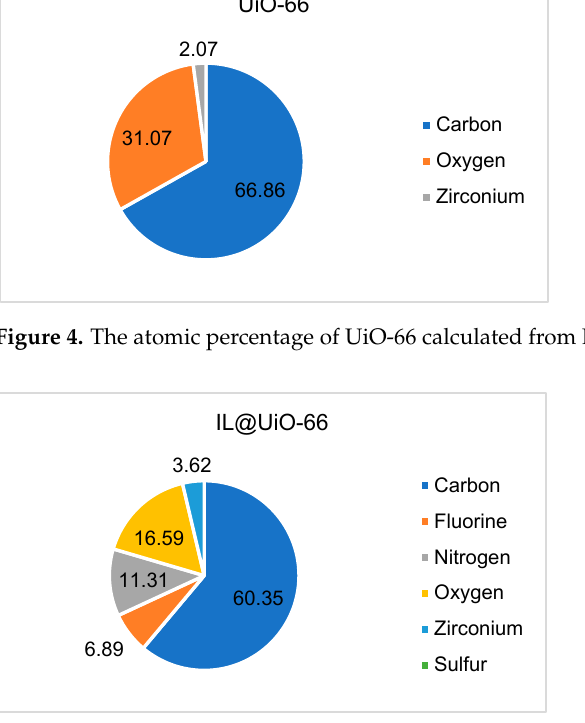
Figure 6. EDX mapping of UiO-66.